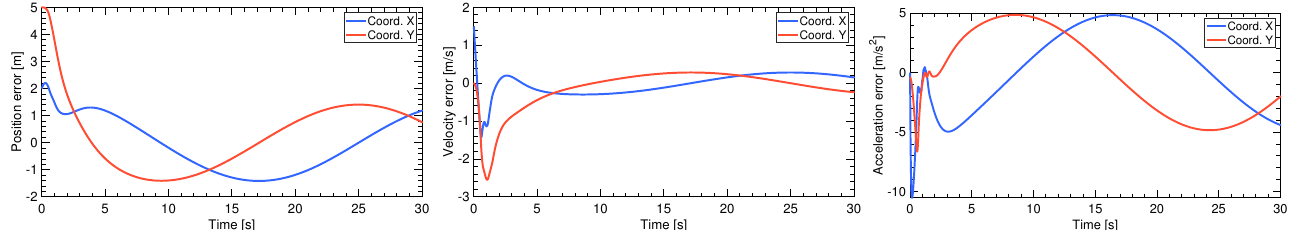
Figure 15. Trajectory following test in case of incorrect knowledge of incorrect mass and inertia: position ( left ), velocity ( middle ), acceleration ( right )